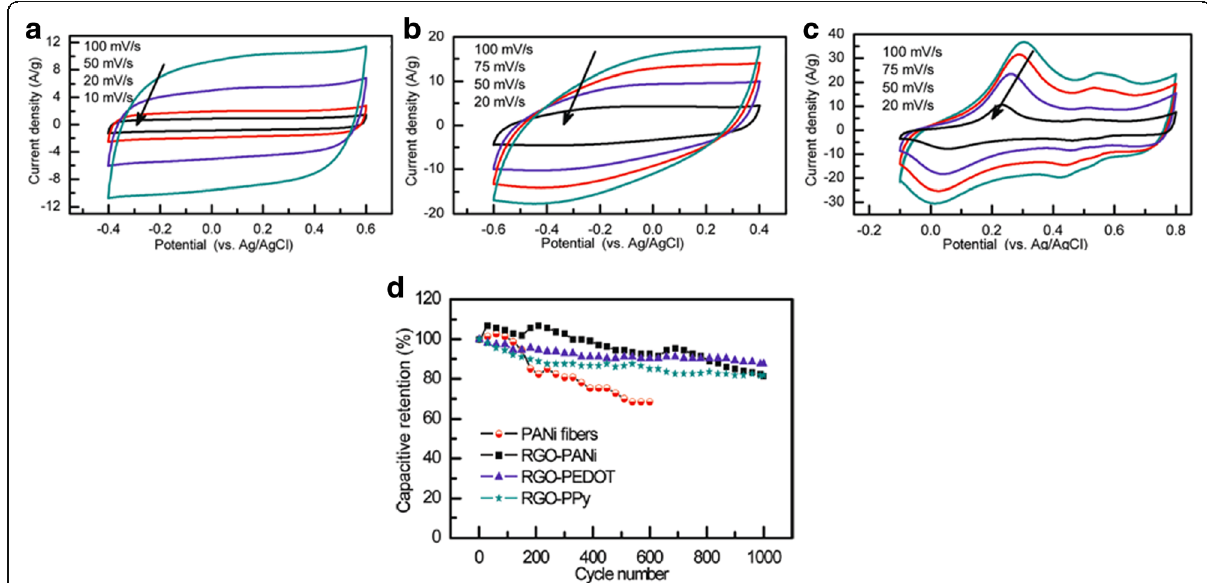
Fig. 9 Cyclic voltammograms of ( a ) RGO-PEDOT ( b ) RGO-PPy, and c RGO-PANi cycle stability of PANi fibers, RGO-PANi, RGO-PEDOT, and ( d ) RGO-PPy during the long-term charge/discharge process. Reprinted with permission from [42]. Copyright 2012 American Chemical